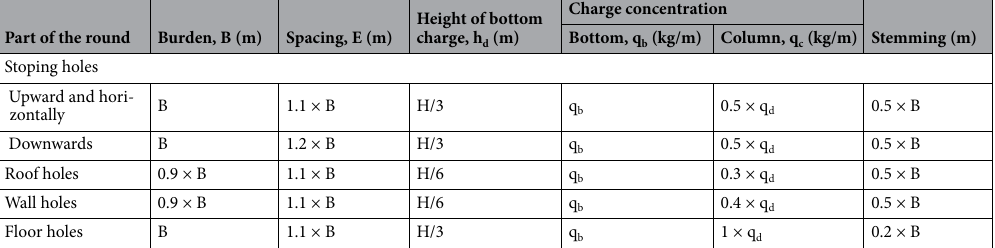
Table 2. Drilling and charging geometry for parallel hole cut 8,10